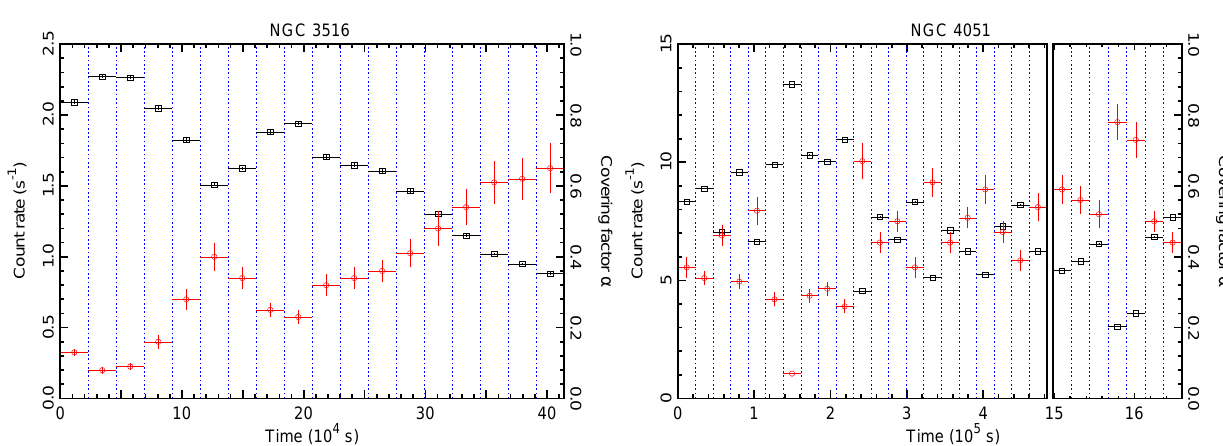
Figure 3: Variations of the observed XIS counting rates (0.2 – 12 keV; black, scale in left) and the partial covering fractions (red, scale in right) for NGC3516 and NGC4051.